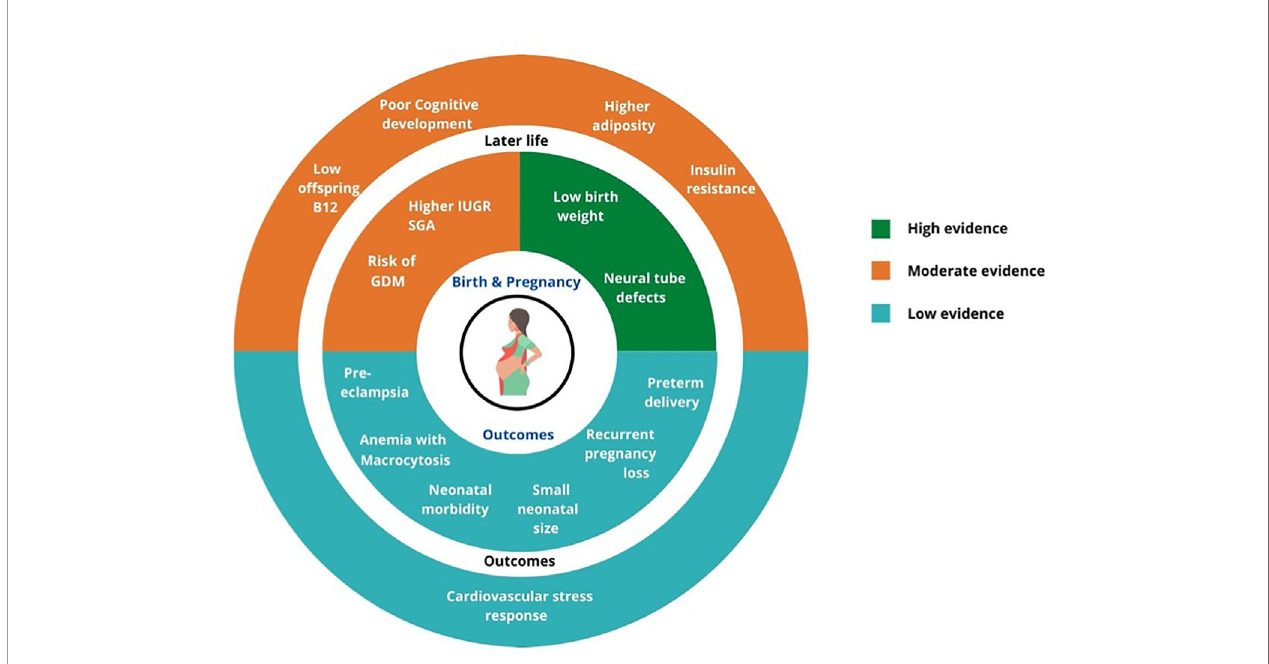
FIGURE 2 | Summary of GRADE evidence for studies on associations of low maternal vitamin B12 and pregnancy and offspring health